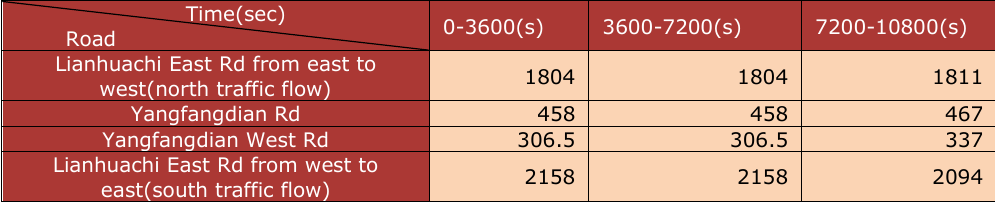
Table 4. The Traffic Flow in Different